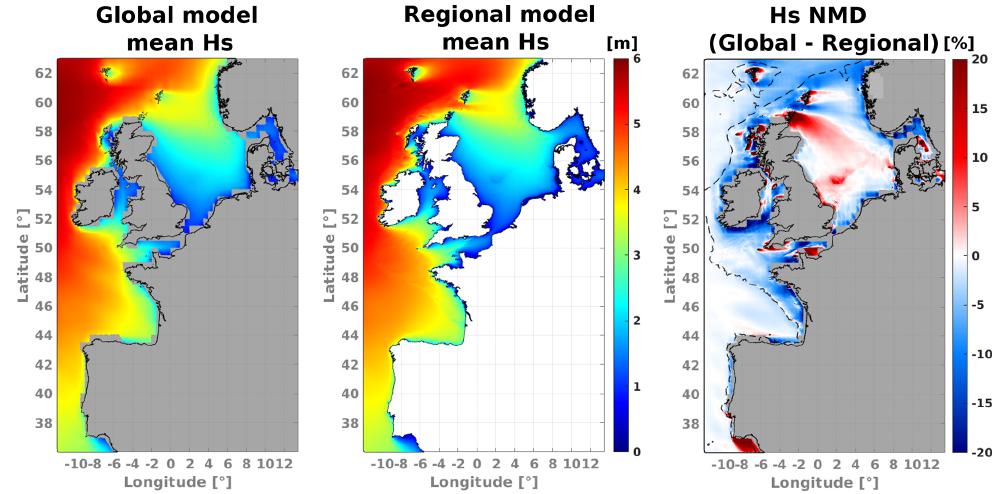
Figure 5. Mean wave height fields from global and regional models and wave height normalized mean differences (NMDs: global − regional). Dashed black lines represent the 400m depth contours. Areas where no wave data are available from the global grid are highlighted with a gray background in left and right panels. Results for February 2011.